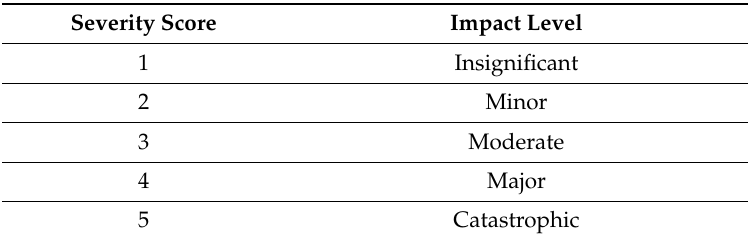
Table 2. Severity score (SS) and associated impact level.